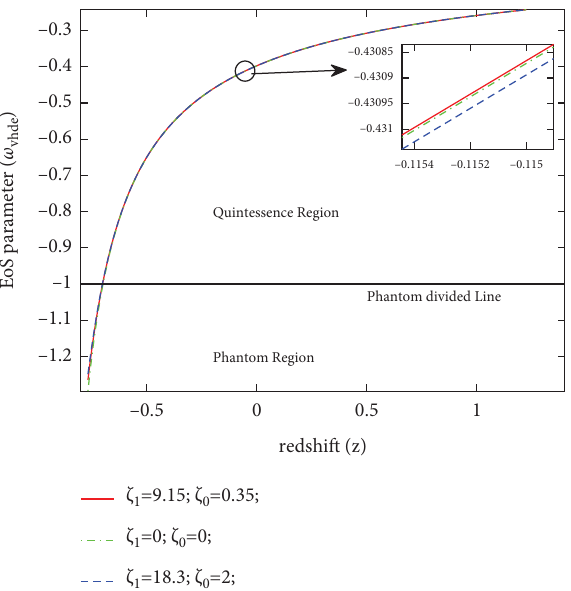
Figure 16: EoS parameter ( ω